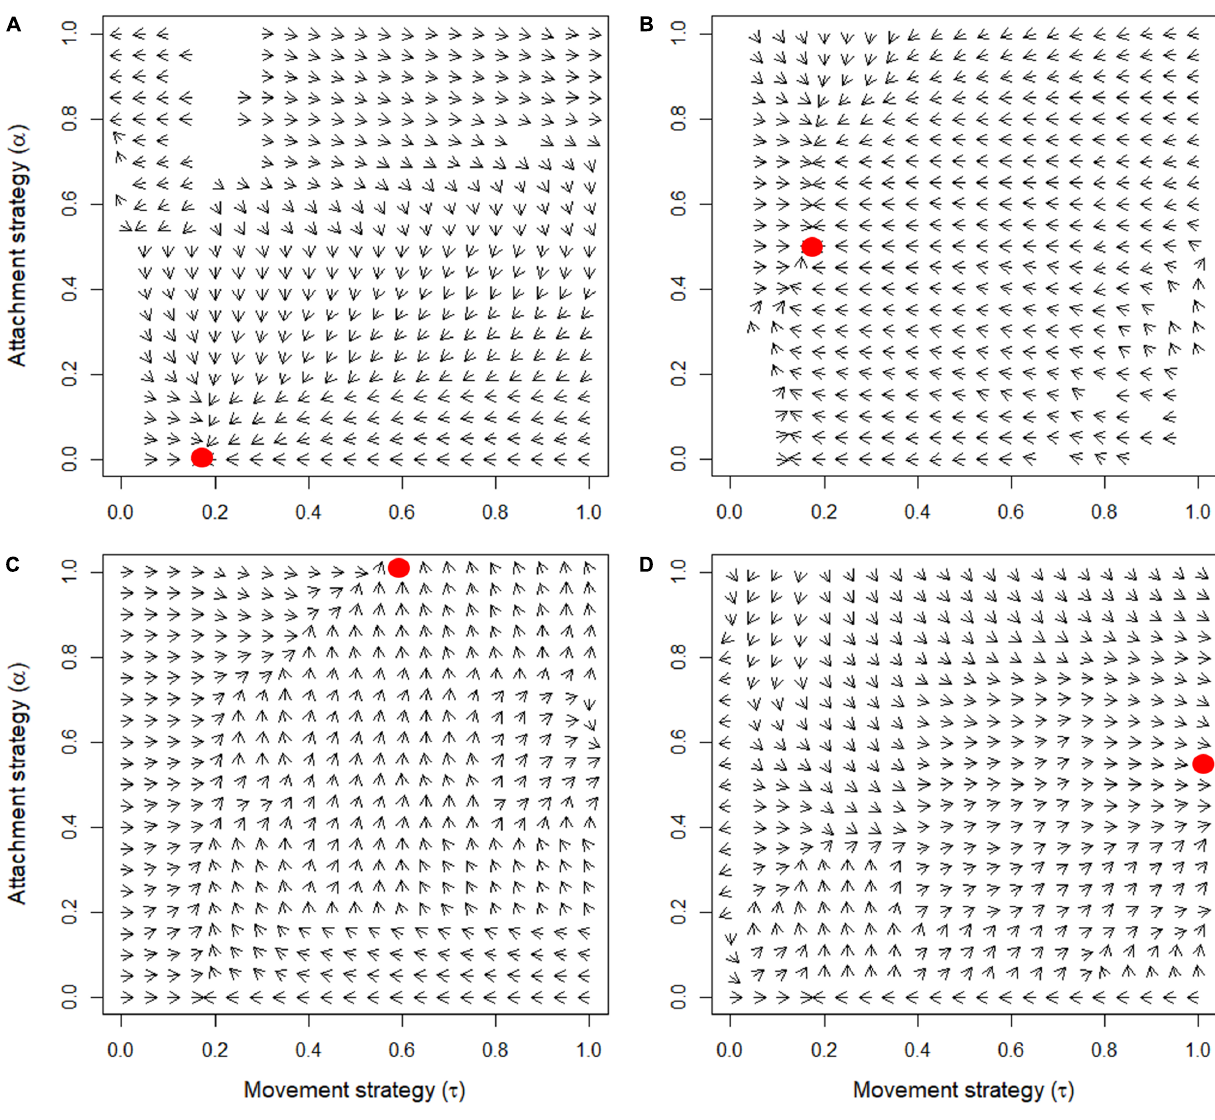
FIGURE 3 | Effect of cost of movement ( κ 1 ) and cost of attachment ( κ 2 ) on the joint evolution of mussel movement and attachment strategies. The red dots correspond to the joint evolutionary attractors and the arrows indicate the direction of evolution. No arrows are shown when the mutants and residents have zero fitness difference. In panel (A) , the population goes extinct, as the attachment strategy evolves to full defection ( κ 1 = 0.01 and κ 2 = 0.1). In panel (B) , scattered distributions emerge after joint evolution of mussel movement and attachment ( κ 1 = 0.1 and κ 2 = 0.01). In panel (C) , labyrinth-producing trait combinations evolve ( κ 1 = 0.0015, κ 2 = 0.0015). In panel (D) dense clumps emerge after evolution toward the evolutionary attractor ( κ 1 = 0.0001 and κ 2 =